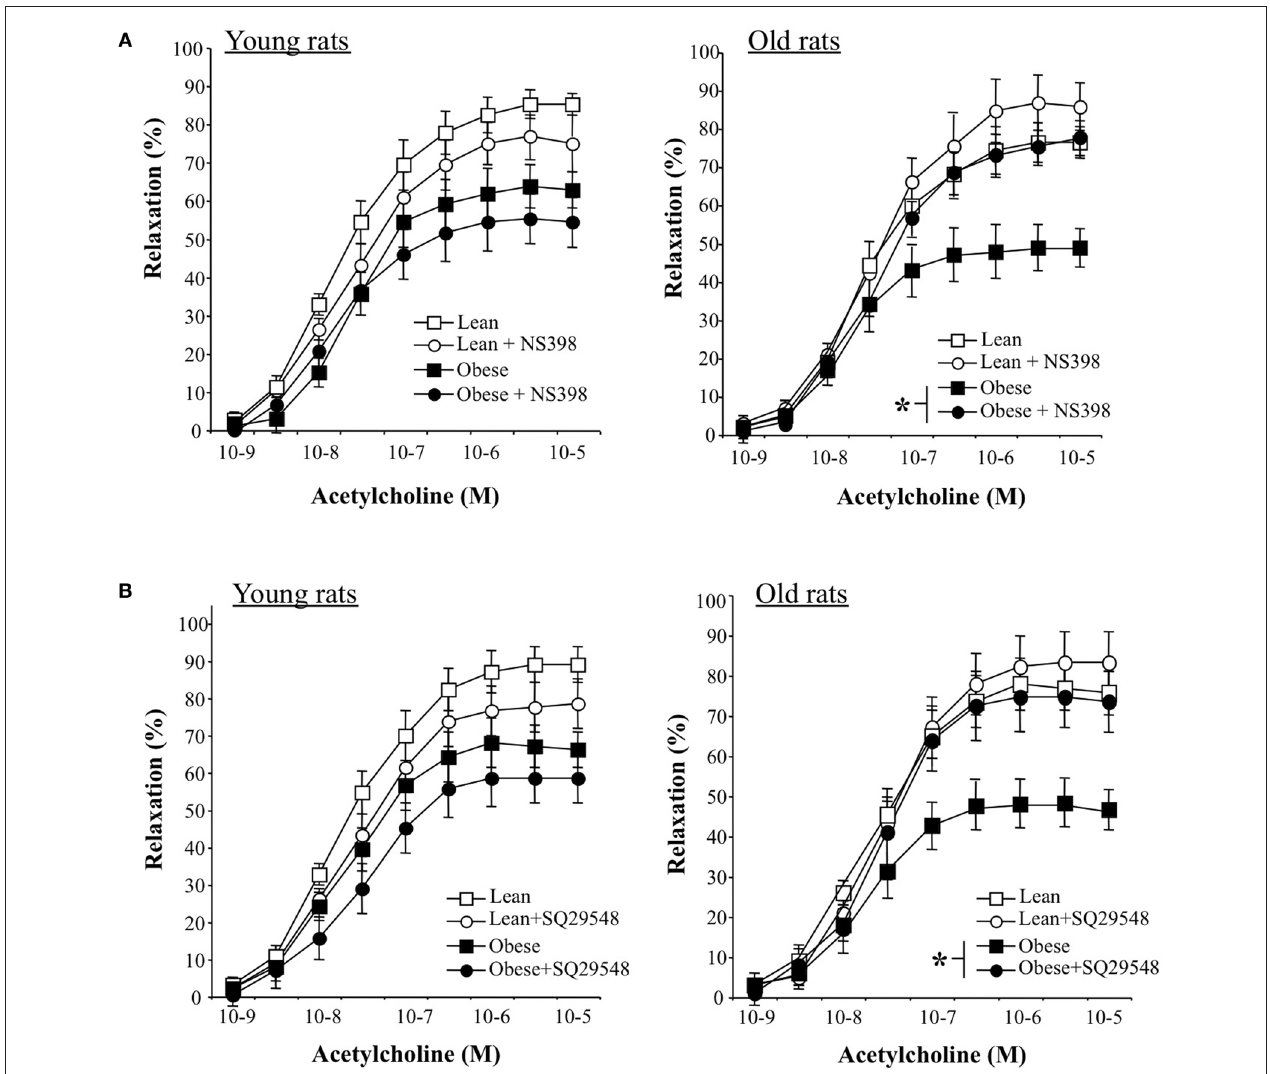
Figure 3 | effect of cOx2 inhibition with Ns398 (A) or TxA arteries isolated from young (A) or old (B) lean and obese Zucker rats . Mean ± SEM is presented ( n = 8 per group). * P < 0.01, effect of NS398 (A) or SQ29548 (B)